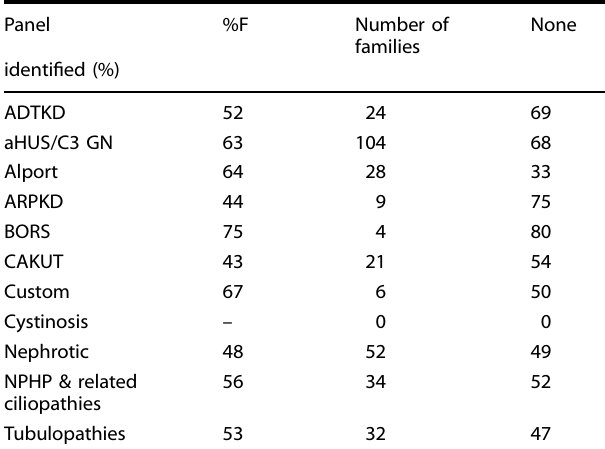
Table 4. Summary of results in which no (likely) pathogenic variant or VOUS was identi fi ed.